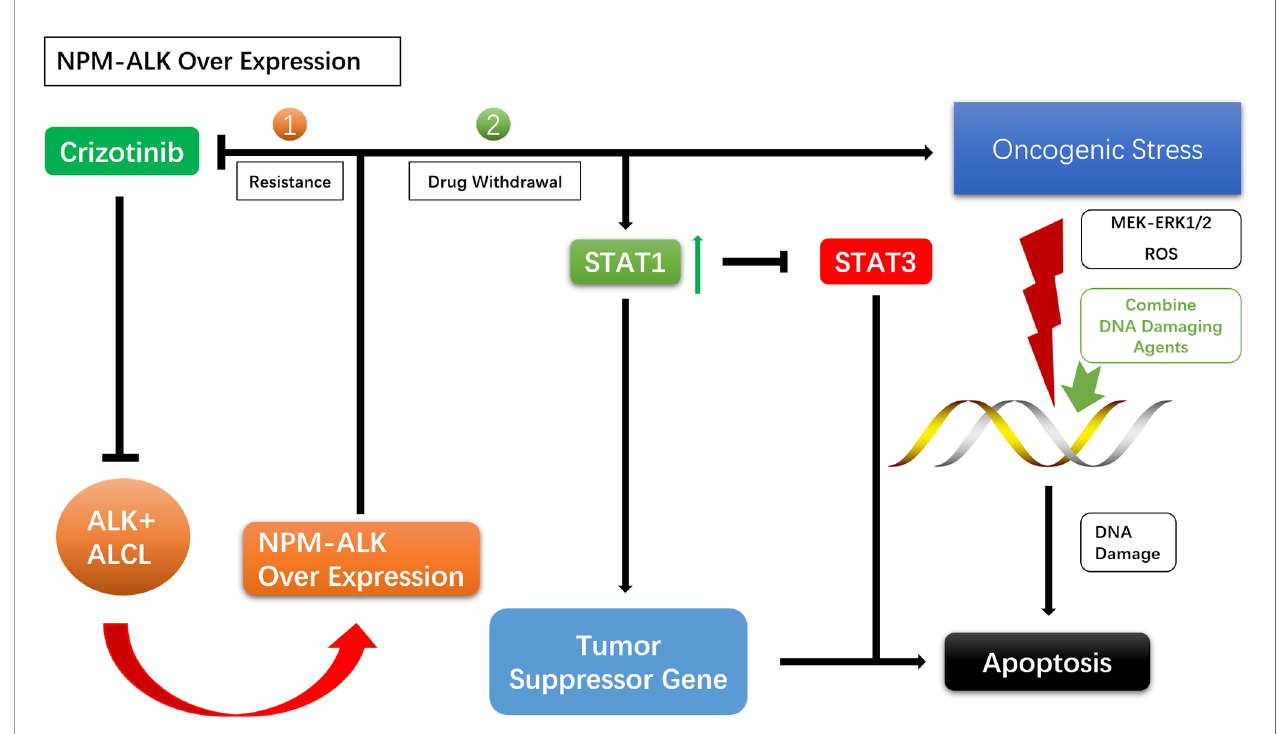
FIGURE 3 | Mechanisms of intermittent